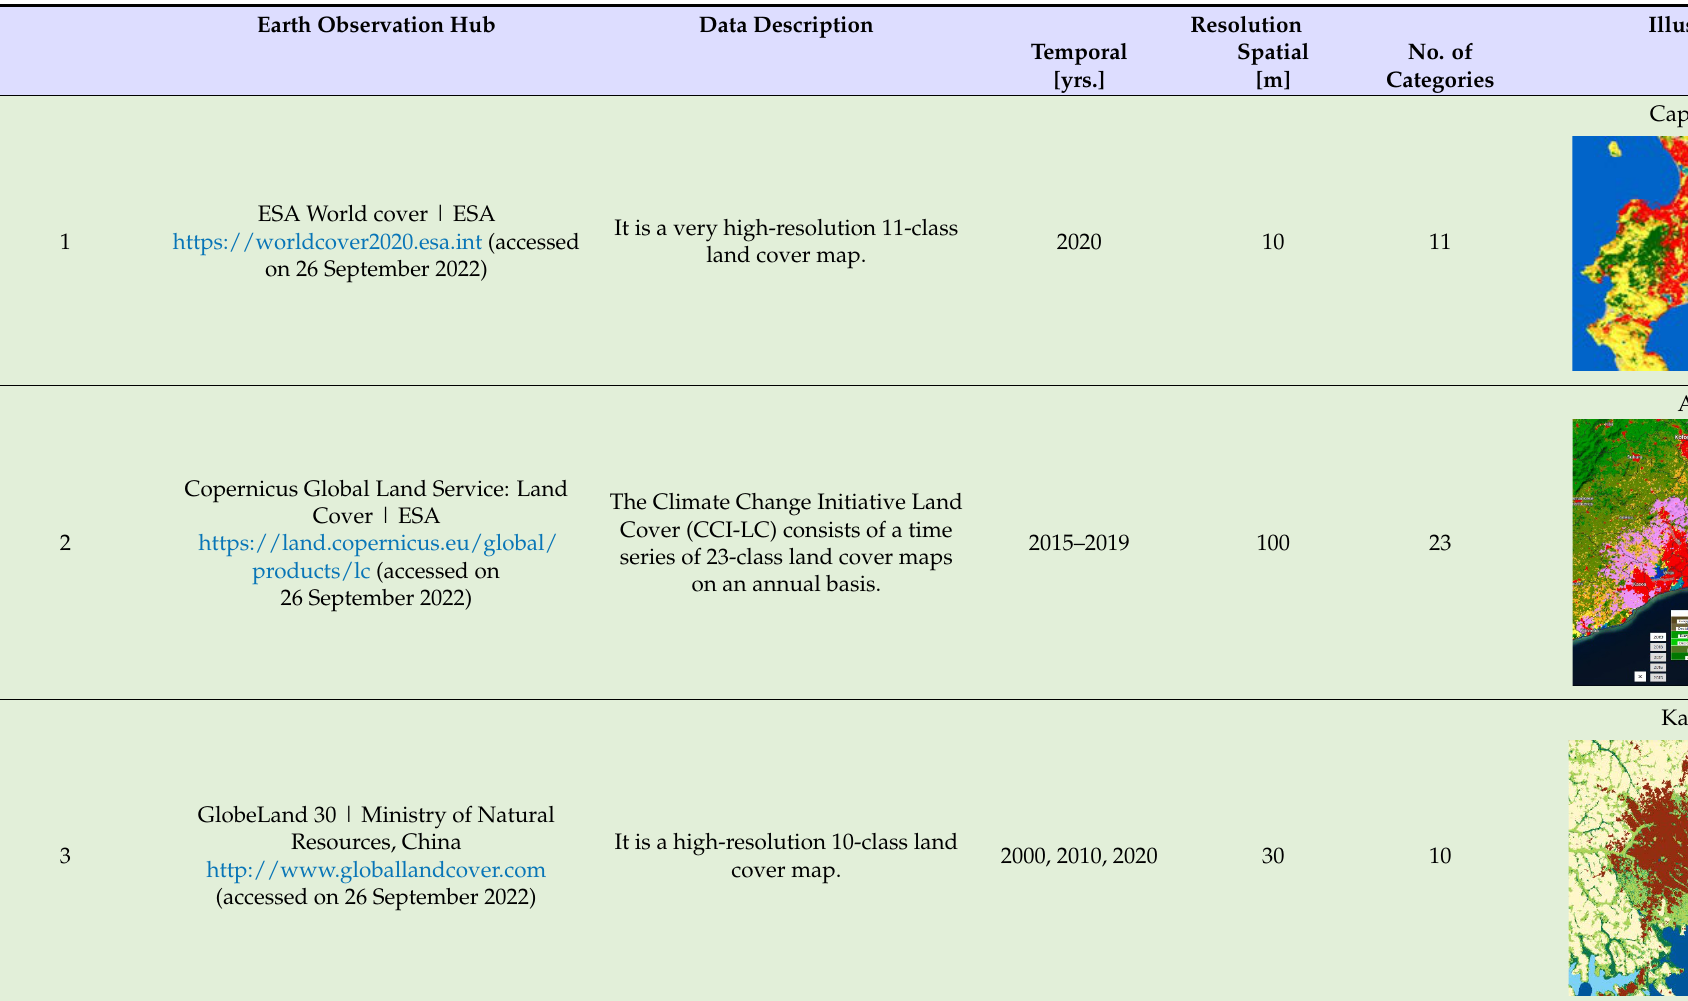
Table 1. Publicly available dataset revealing different characteristics of land cover.